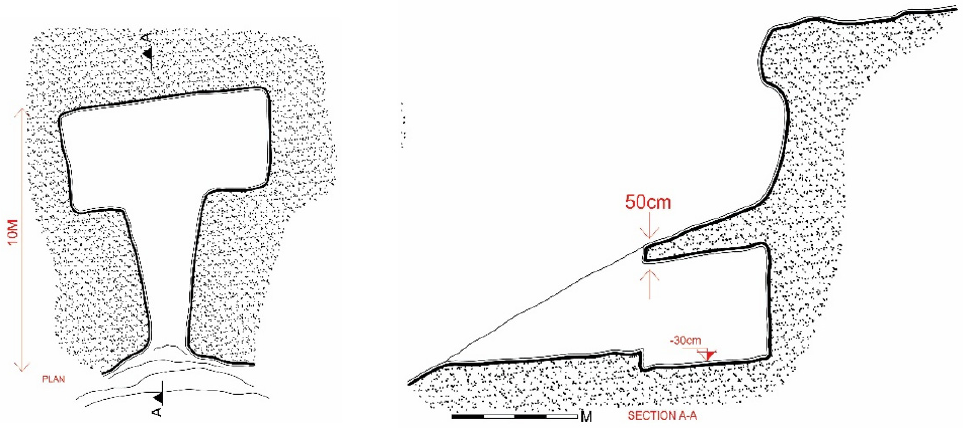
Figure 18. The second stage of excavation (excavation of semi − open space, i.e., Soffeh) in cross-section and plan view.